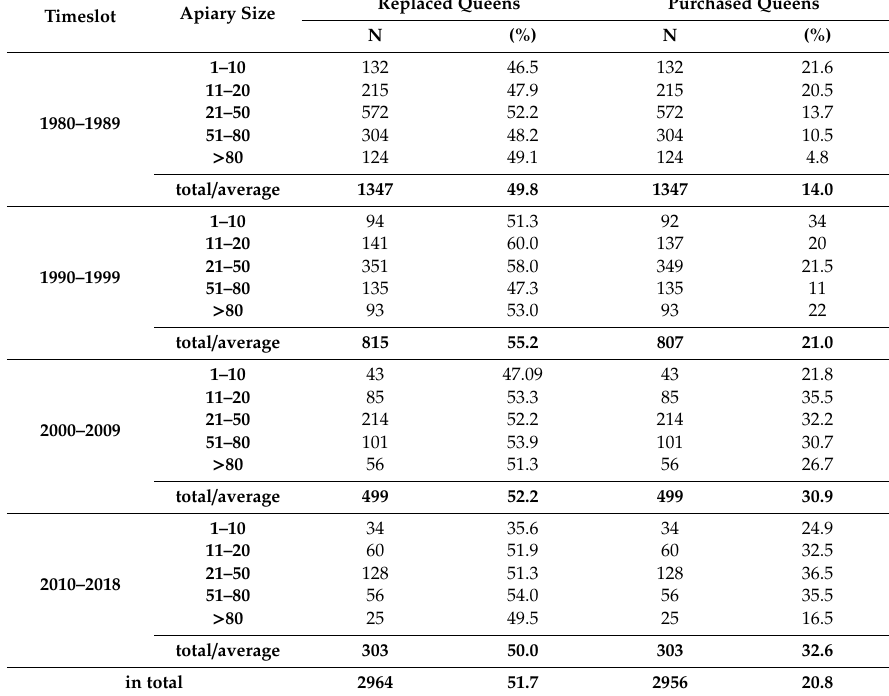
Table A3. Numerical characteristics of replaced queens, including purchased ones, analyzed by decade timeslot and apiary